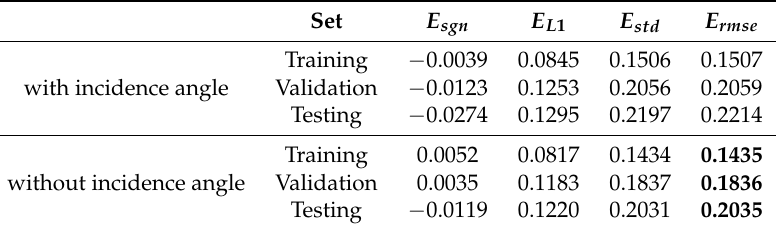
Table 5. The average error statistics for networks trained with or without incidence angle data using CNN on the Gulf of Saint Lawrence data.